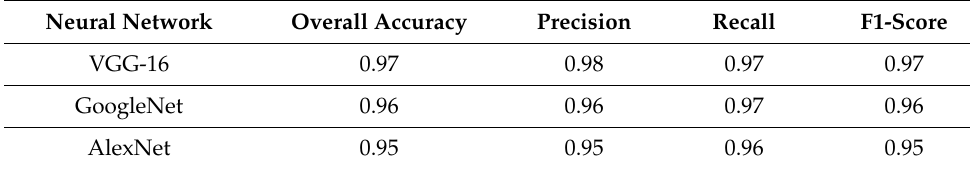
Table 2. Validation results of DCNNs models (AlexNet, VGG-16 and